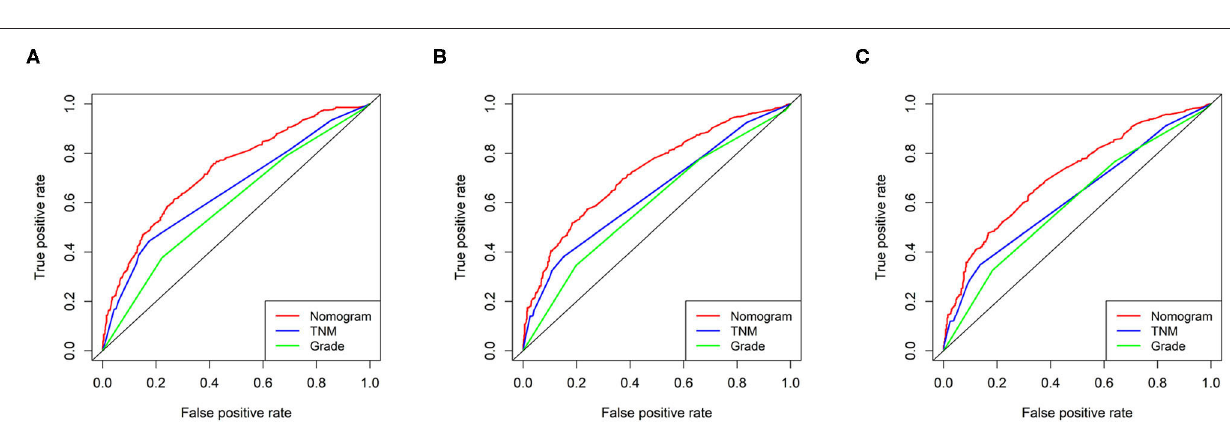
FIGURE 2 | ROC curves of the ability of the nomogram, TNM staging and grade to predict 1-, 2- and 3-year overall survival in the training cohort. (A) 1 year time-dependent ROC curve. (B) 2 year time-dependent ROC curve. (C) 3 year time-dependent ROC curve. each patient were obtained by adding the score of every prognostic